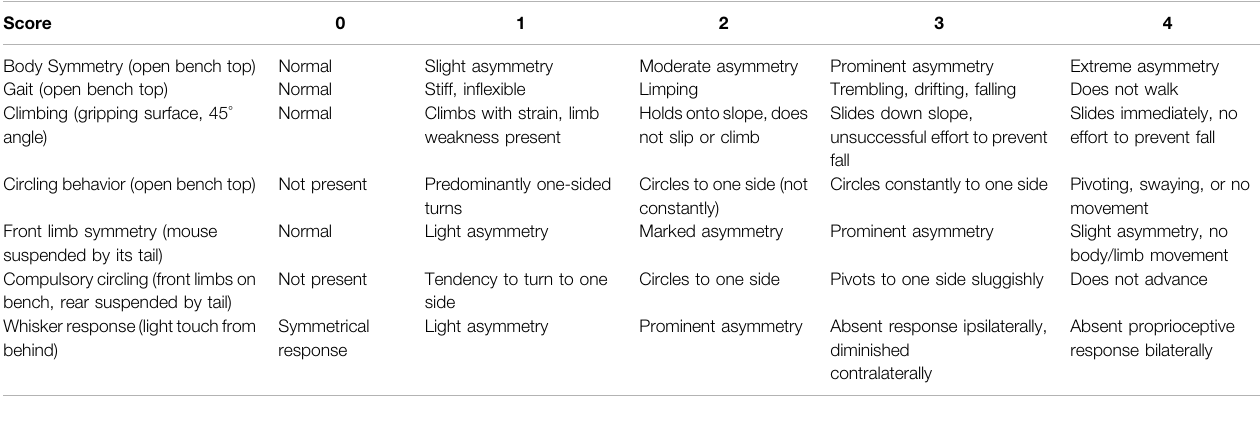
TABLE 3 | Focal de fi cits (0-28) scoring scale (Clark et al., 1997).